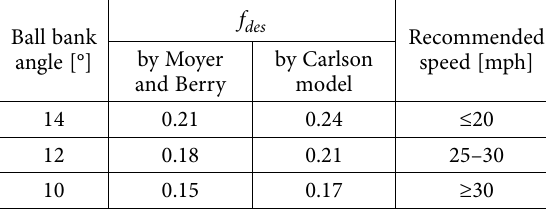
Table 2. Design side friction factors and ball bank